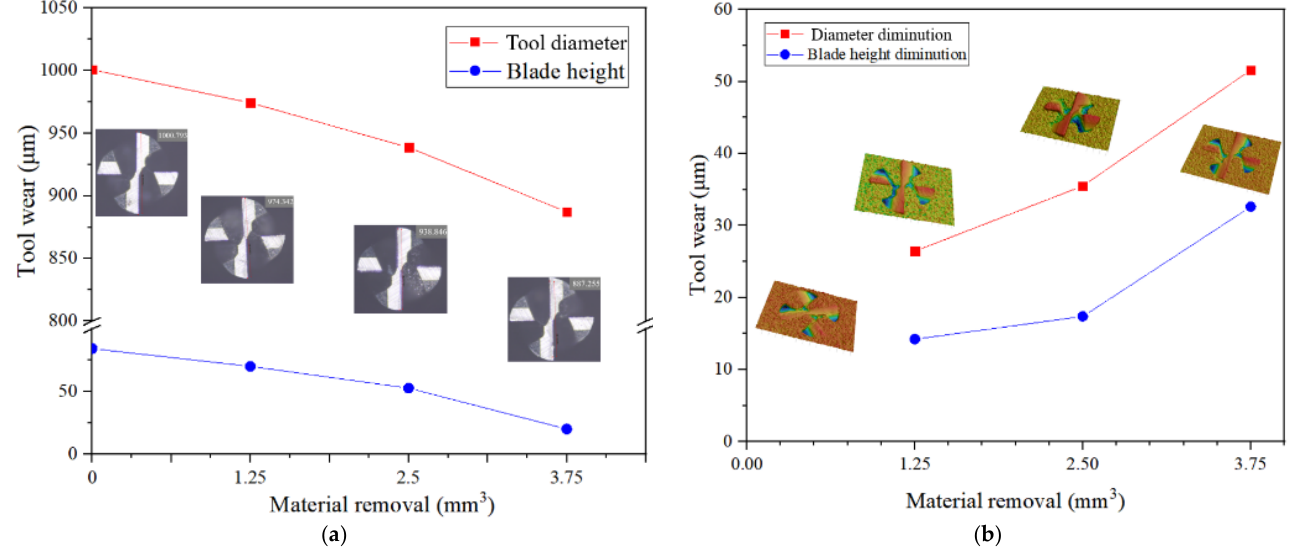
Figure 13. Effect of material removal on micro milling cutter wear. ( a ) Change of tool diameter and blade height; ( b ) change of tool diameter diminution and blade height diminution.